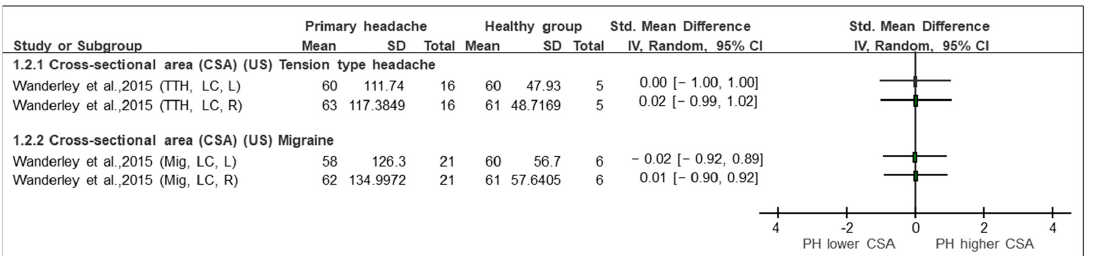
Figure 3. Forest plot of cross-sectional area based on ultrasound imaging. Graph explains the direction of change in muscle size in patients with primary headache towards a lower or higher CSA. TTH: tension type headache, Mig: Migraine, CSA: cross-sectional area, US: ultrasound imaging, LC: longus colli, L: left, R: right, Lower CSA: smaller area, Higher CSA: larger area. Authors: Wanderley et al. [36] .